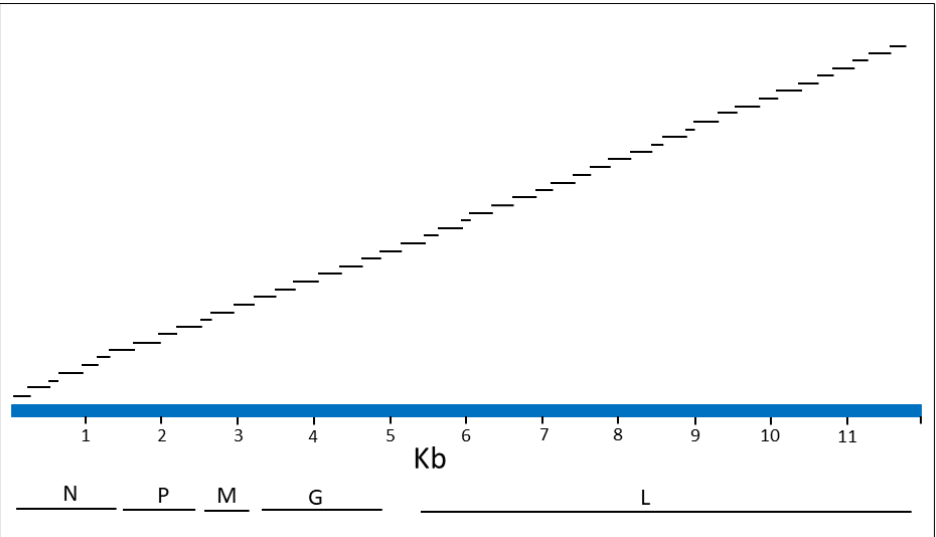
Figure 1. A schematic of the Ampliseq for Illumina primer panel. The 11.967 Kb RABV consensus sequence genome (positive sense) is represented by a blue bar above which the locations targeted by the 47 panel primer pairs are shown. For each of the 47 amplicons only the internal sequence is illustrated; amplicon size is 50 bp longer with inclusion of the primers. Illustrated below the genome are the locations of the five viral genes that encode products as follows: N, nucleoprotein; P, phosphoprotein; M, matrix protein; G, glycoprotein; L, polymerase.